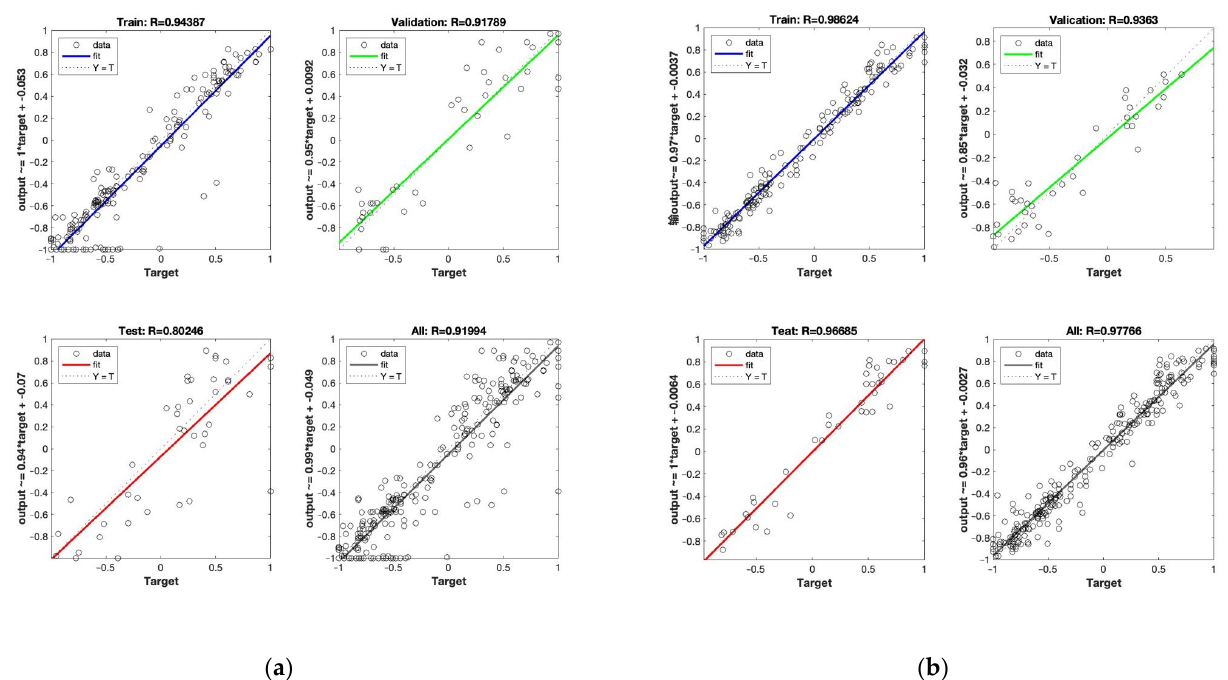
Figure 6. ( a , b ) are two graphs showing the relationship between the training set, the validation set, and the test set predicted value and the actual value when the BP and CPA-BP model predicts the bond strength of plywood.